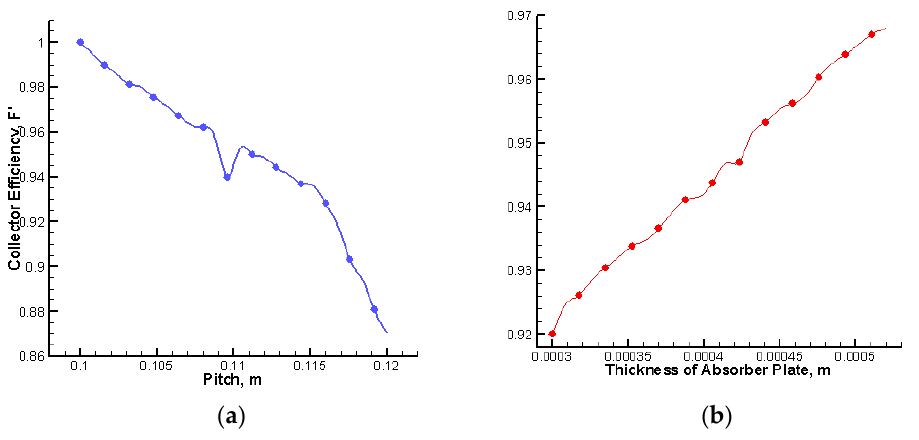
Figure 7. Changes in the efficiency of the collector: ( a ) the pitch of the tubes; ( b ) the thickness of the absorbing plate.